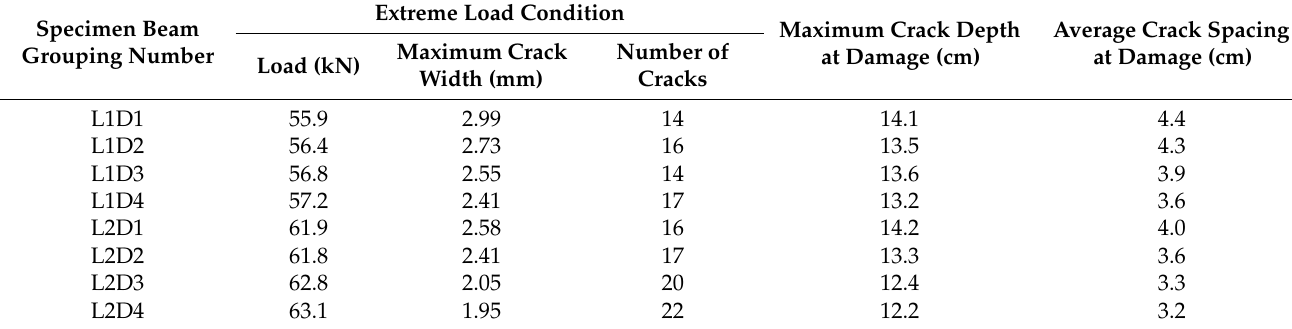
Figure 16. Maximum fracture depth curves after creep. Table 8. Measured crack data.